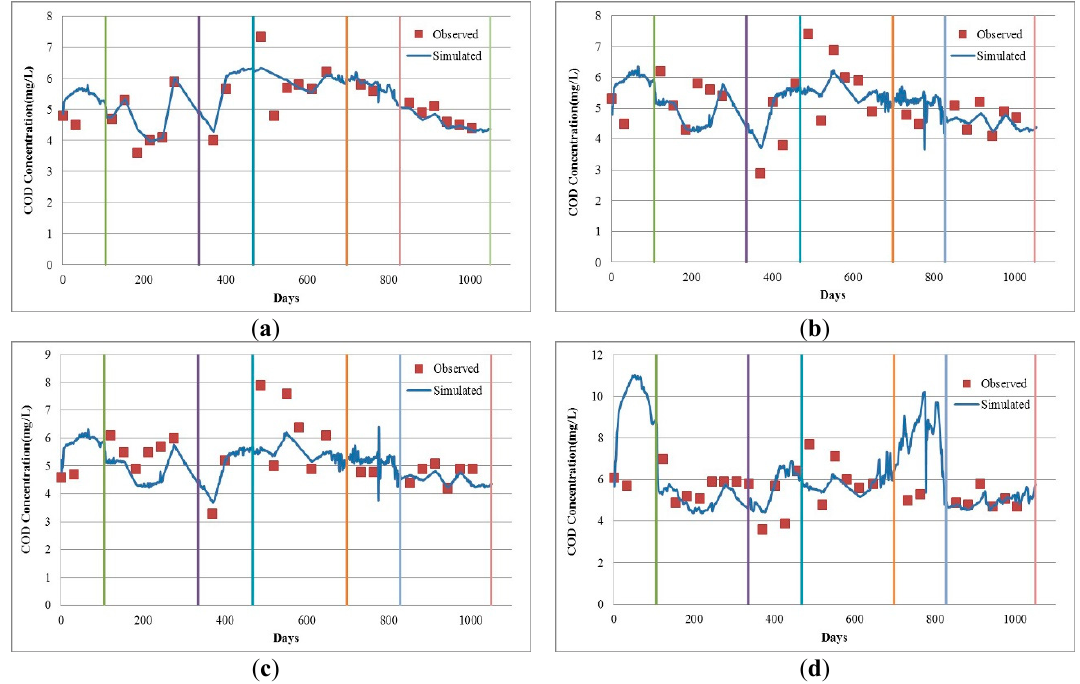
Figure 6. Result contrast charts for observed and simulated values of COD Cr in the Mudan River trunk stream. ( a ) Wenchun Bridge; ( b ) Hailang; ( c ) Jiangbin Bridge; ( d ) Chai River Bridge. Table 2. Statistical results for COD Cr simulated and observed values in the Mudan River trunk stream model.